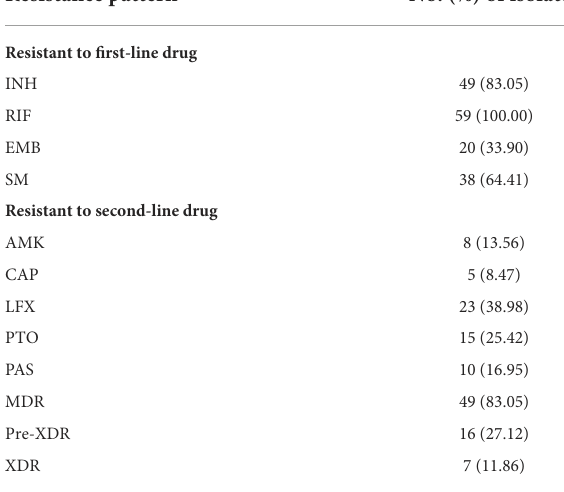
TABLE 1 Drug resistance profiles of RR-TB clinical samples (culture-based DST). Resistance